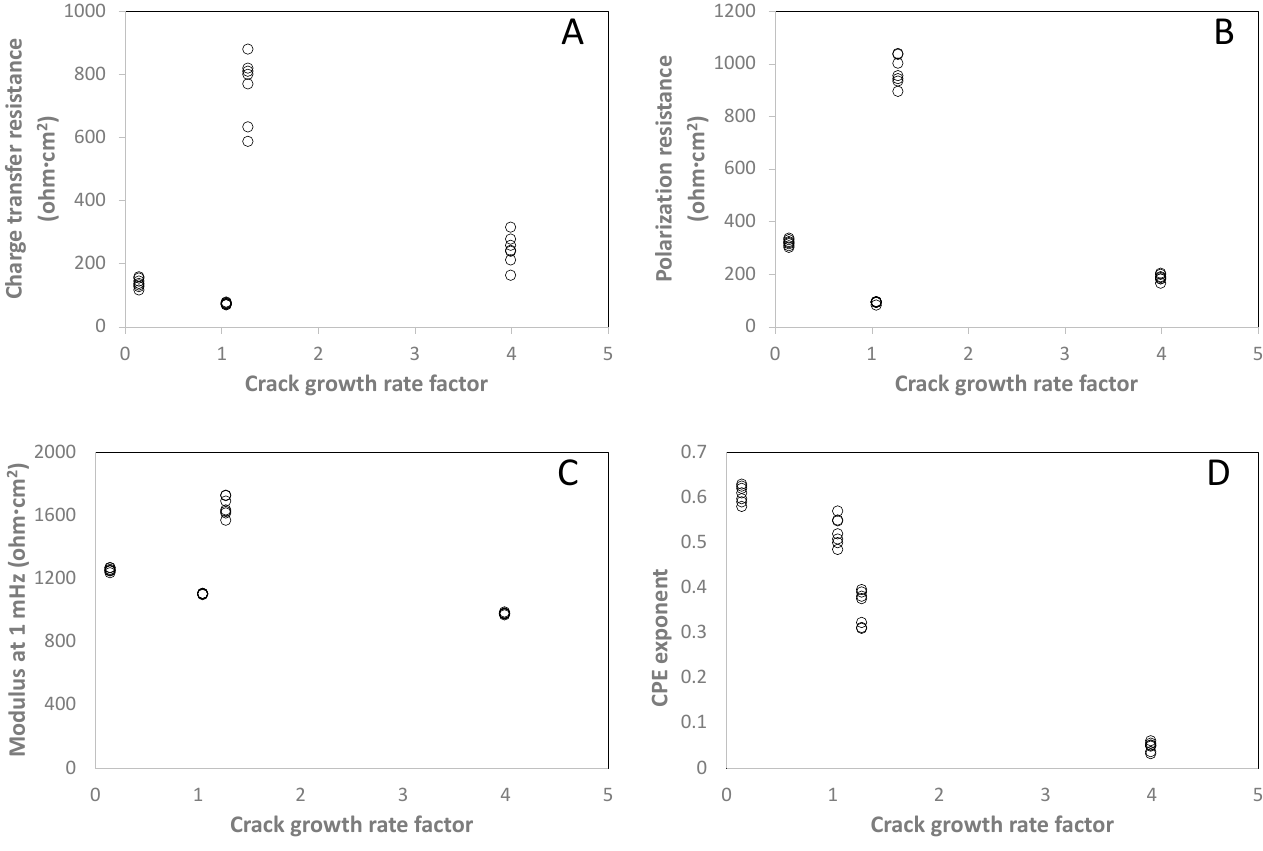
Figure 15. Impedance fit parameters (R ct , R p , R z and n ) as a function of crack growth rate factor: ( A ) Charge transfer resistance R ct , ( B ) Polarization resistance R p , ( C ) low frequency modulus R Z , ( D ) CPE exponent n .